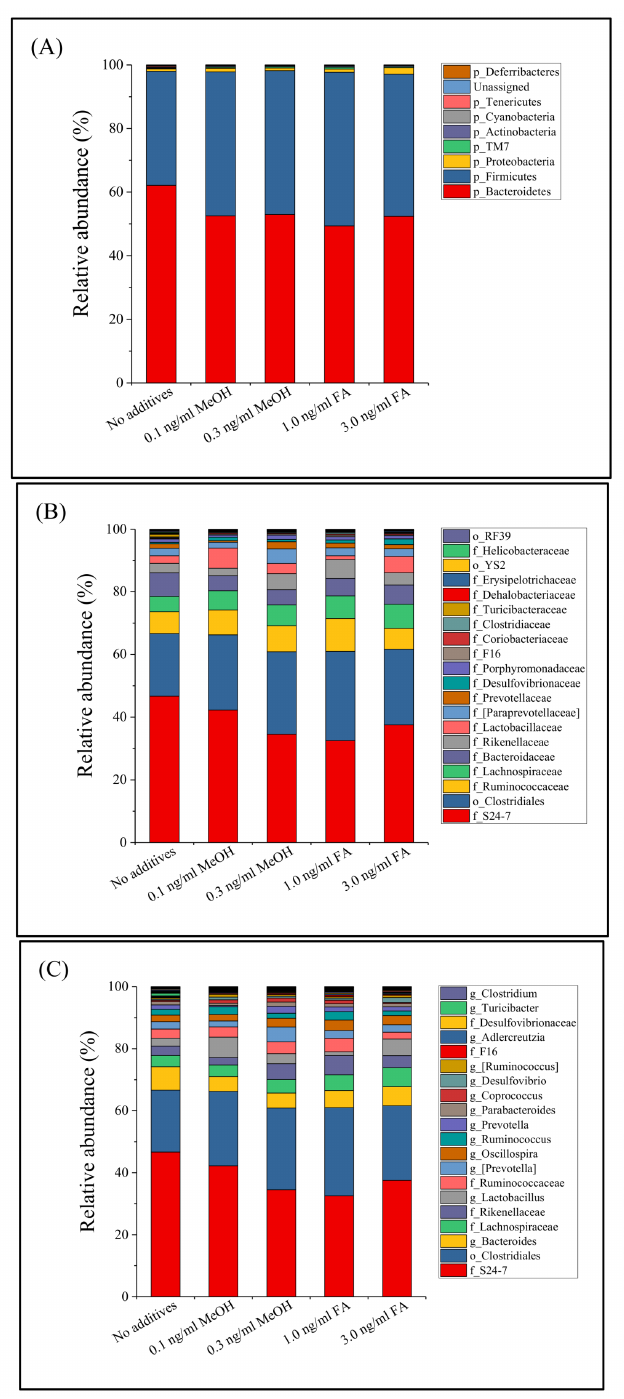
Figure 1. Fecal microbiota composition profiles at the phylum level ( A ), family level (( B ), top 20 families with the most relative abundance were labeled) and genus level (( C ), top 20 genera with the most relative abundance were labeled) in mice treated with different doses of MeOH or